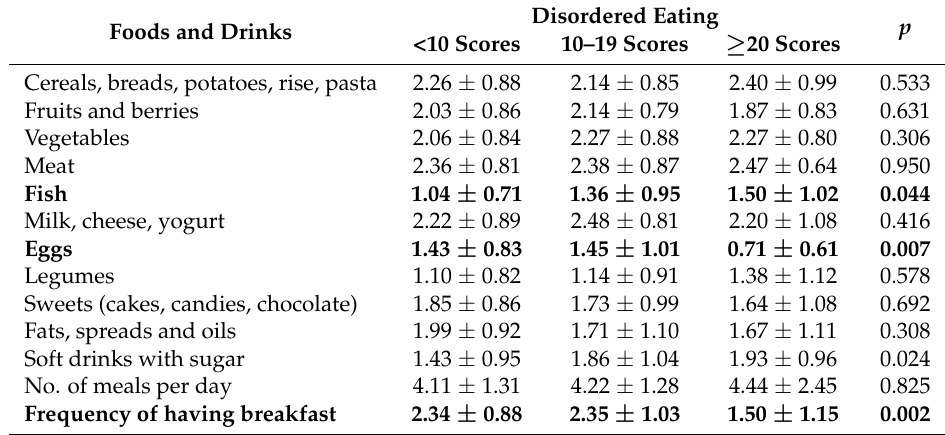
Table 7. Comparison of nutrition habits of adolescent boys in groups of disordered eating (m ± SD) 1 , ( n = 579).